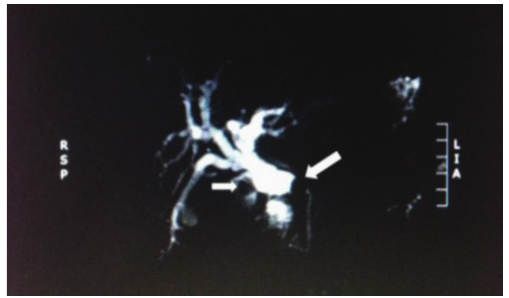
F 4: Magnetic resonance cholangiography (MRC) showing presence of one large stone (45mm) in a gallbladder with thick walls and one smaller stone (12mm) in the cystic duct with a �stula involving the common bile duct which was dilated above the �stula level and normal below . e white arrows show the two